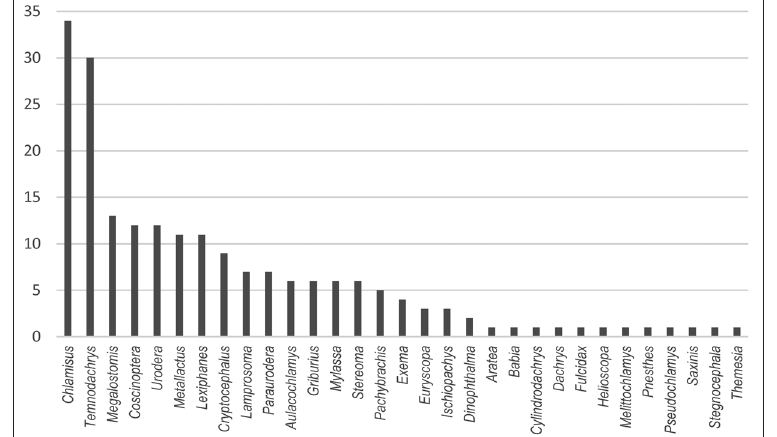
Figure 40. Species number by genus.